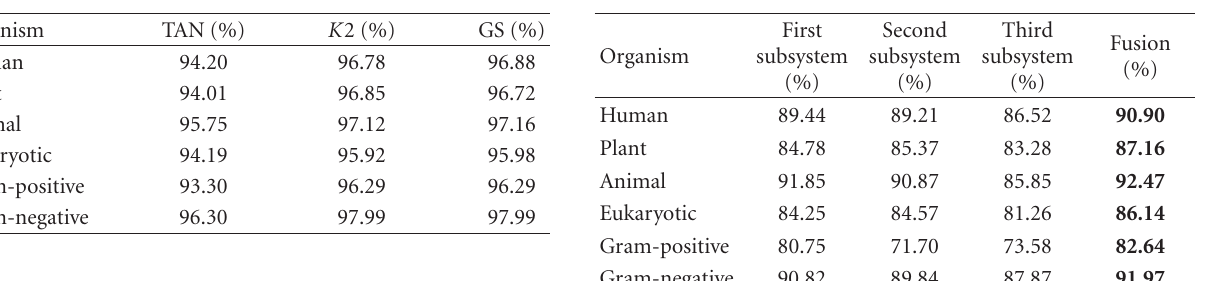
Table 7: The accuracy of some Bayesian network classifiers in Matlab by first subsystem.